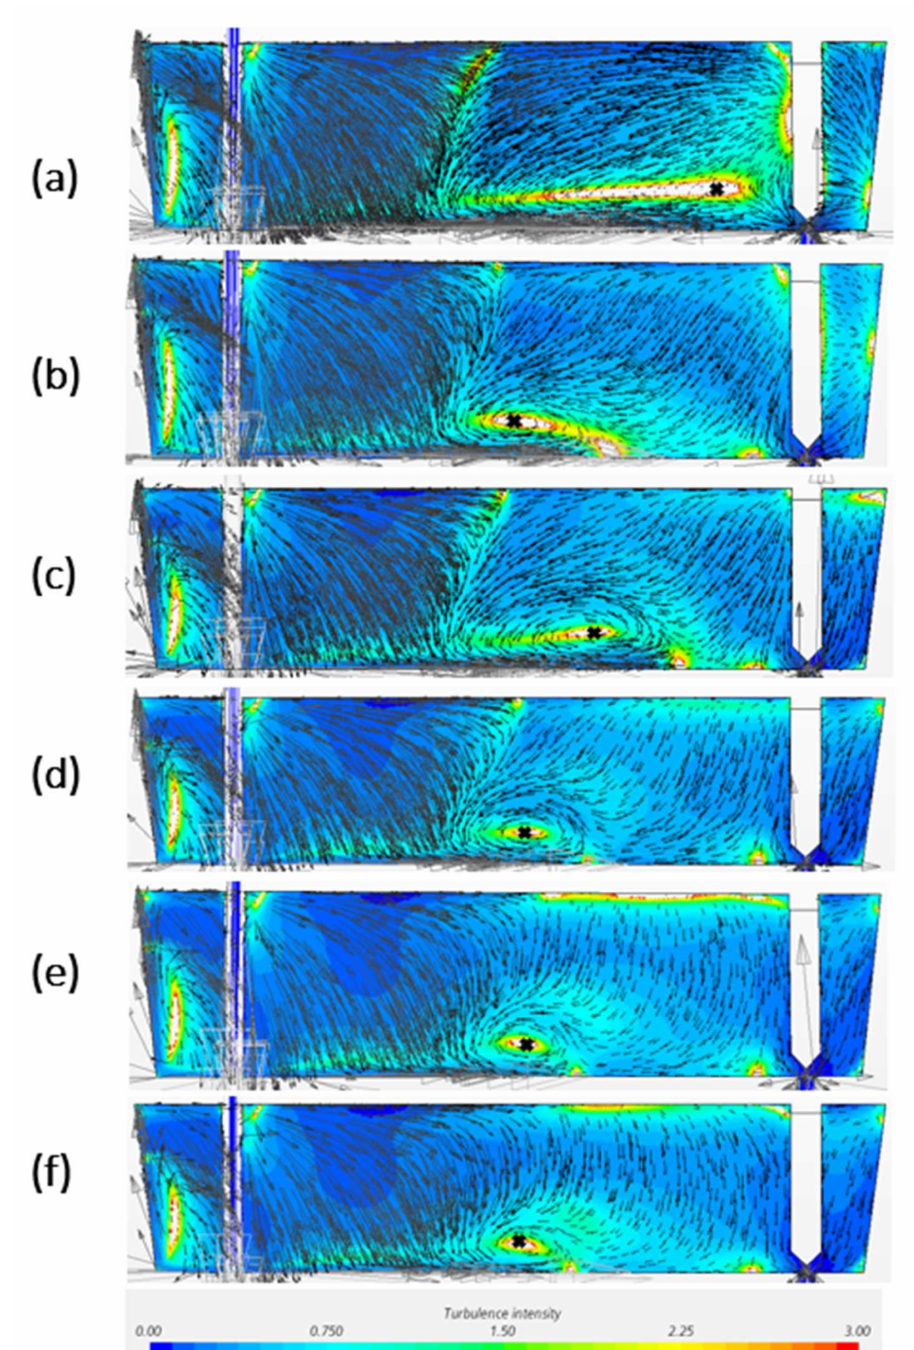
Figure 4. Turbulence intensity and velocity profile of the CFD models with mesh size of ( a ) 0.0045 m, ( b ) 0.005 m, ( c ) 0.0055 m, ( d ) 0.006 m, ( e ) 0.0065 m, ( f ) 0.007 m on symmetry plane. In comparison of CFD modelling results in Figure 4 with experiment measurement in Figure 3, the CFD models with mesh size 0.0055 and 0.006 m have been considered as a better prediction. The model with 0.006 m mesh shows the best prediction of all the four high turbulence regions, as well as a rather good agreement of vortex center (x/L 1 = 0.5). However, when it comes to the recirculation zone shape, 0.0055 m gives a recirculation area between 0.35 < x/L 1 < 0.55, which is better in agreement with experiment measurements than the prediction from 0.006 m